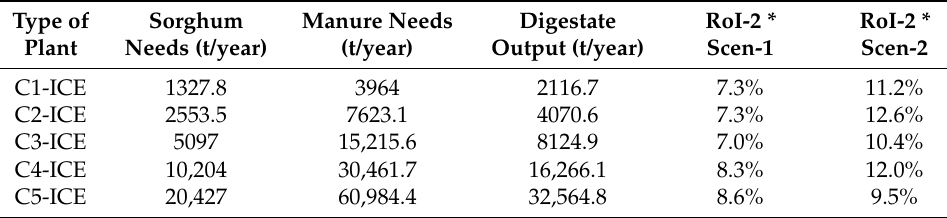
Table 5. Feedstock needs and Return on investment including biomass cost (Scenario